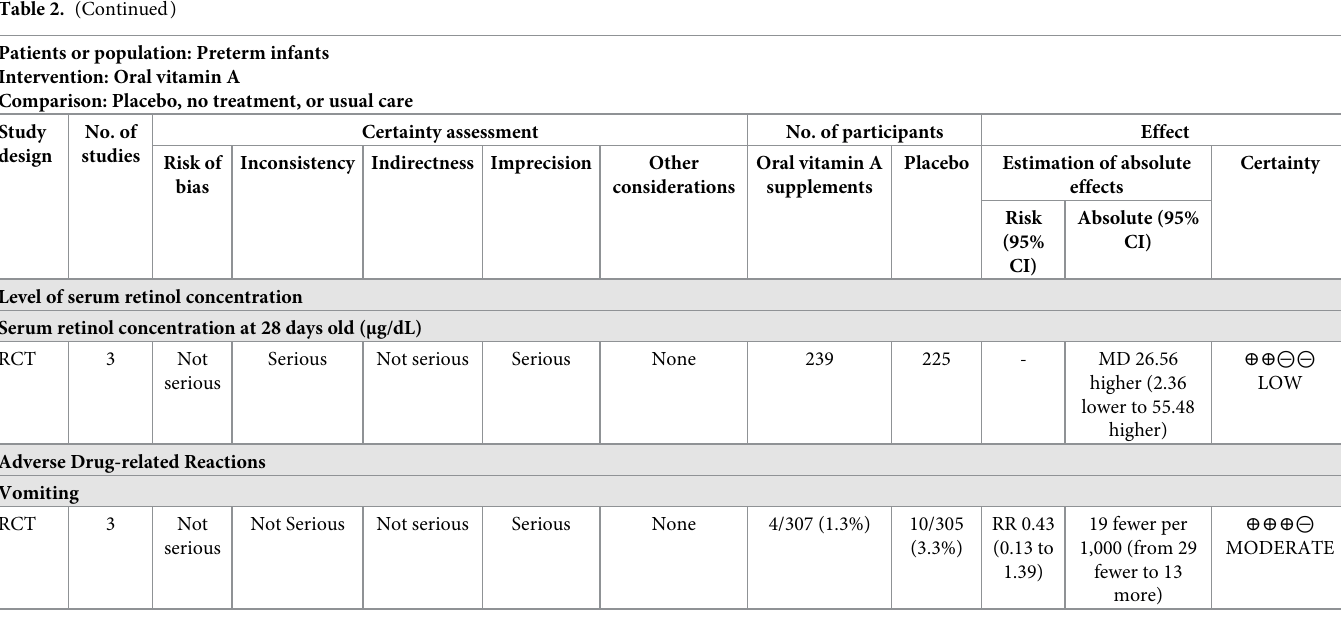
Patients or population: Preterm infants Intervention: Oral vitamin A Comparison: Placebo, no treatment, or usual